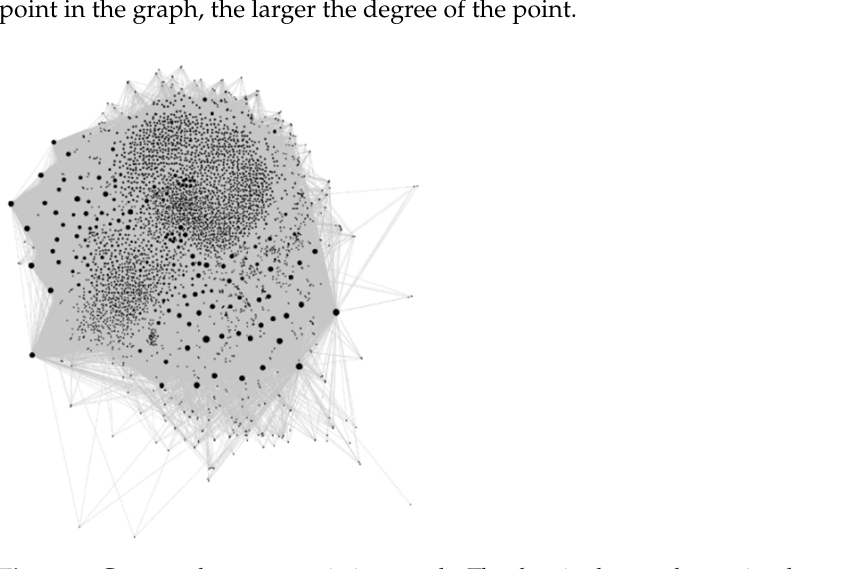
Figure 6. Generated event association graph: The dots in the graph are visual representations of events in the association graph, and the larger the dots, the more events they are associated with. The event node information in the graph includes the event itself, domain, and time information, and the edges are the relationships between events.